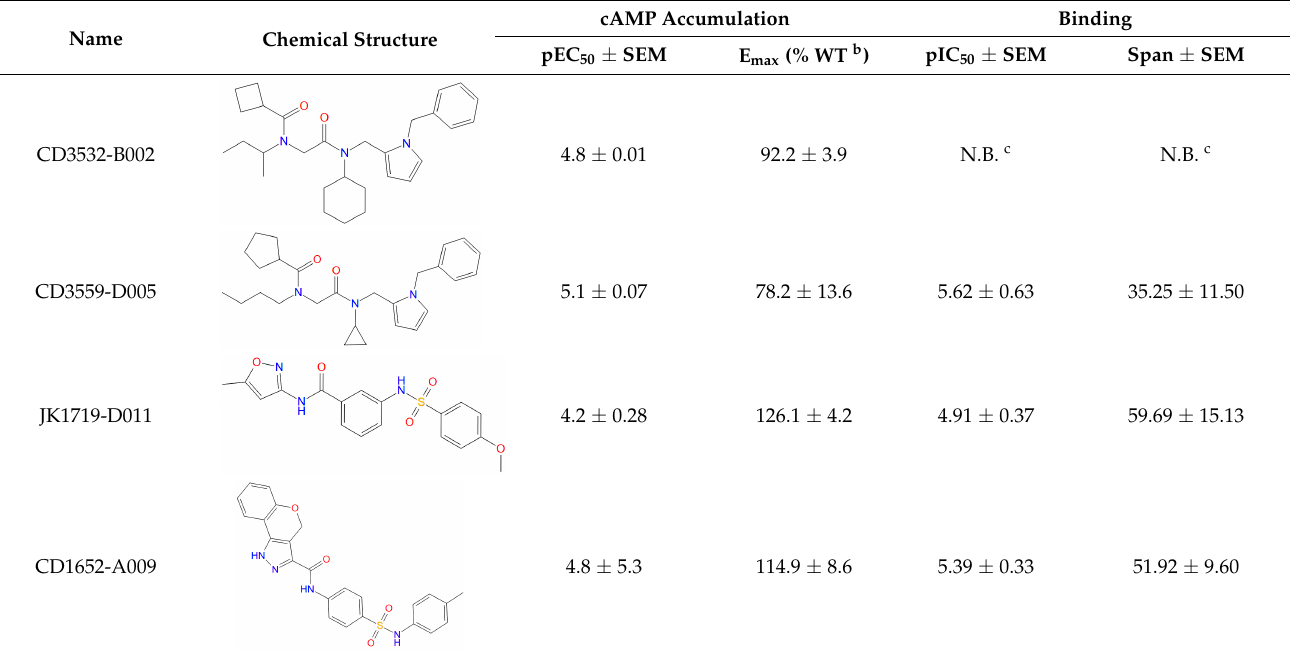
Table 4. Experimentally validated analogues of new PAMs a .